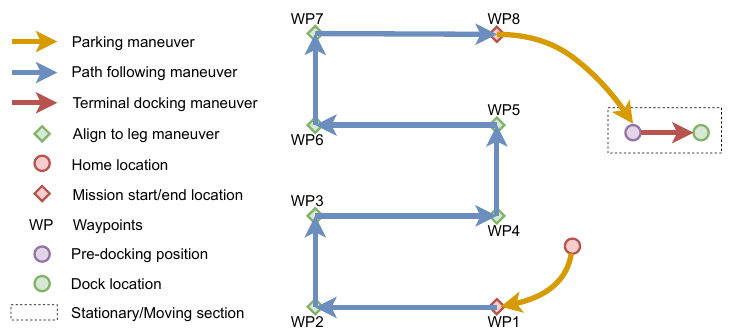
Figure 11. Lawn mover Profile: Representation of various locations, way-points, and maneuvers involved for the complete survey mission. Table 3. Mission parameters. All the positions are defined w.r.t. the world frame. Parameter